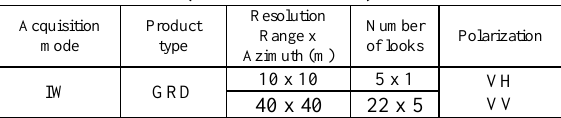
Table 1. The characteristics of the Sentinel 1A data (ESA-Sentinel